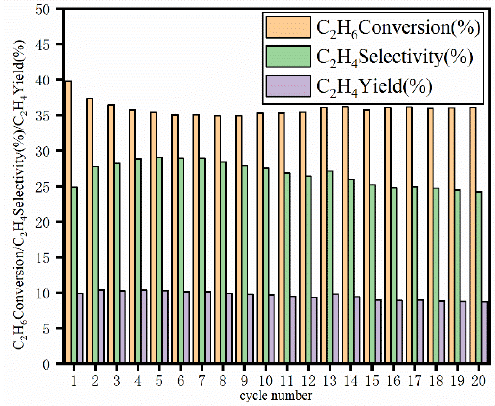
Figure 7. The ethane ODH reaction performances of different oxygen carriers at ( a ) 650 °C, ( b) 675 °C and ( c) 700 °C (GHSV = 1200 mL/h·g).